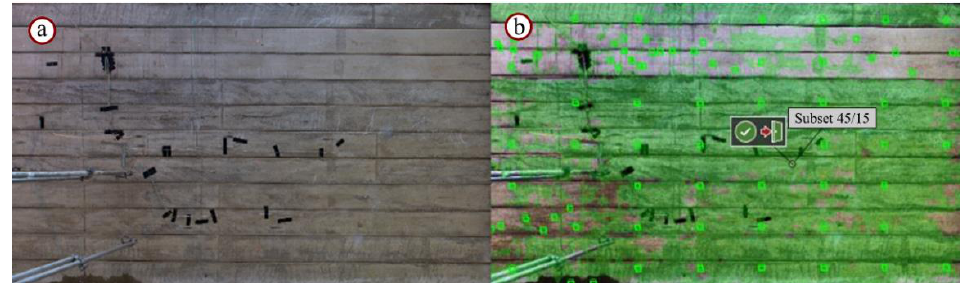
Figure 15. Raw pattern recognition for Strip 1 (Canon 6D). ( a ) Image of the captured surface with- out surface pattern. ( b ) Recognized areas with subset 45/15.